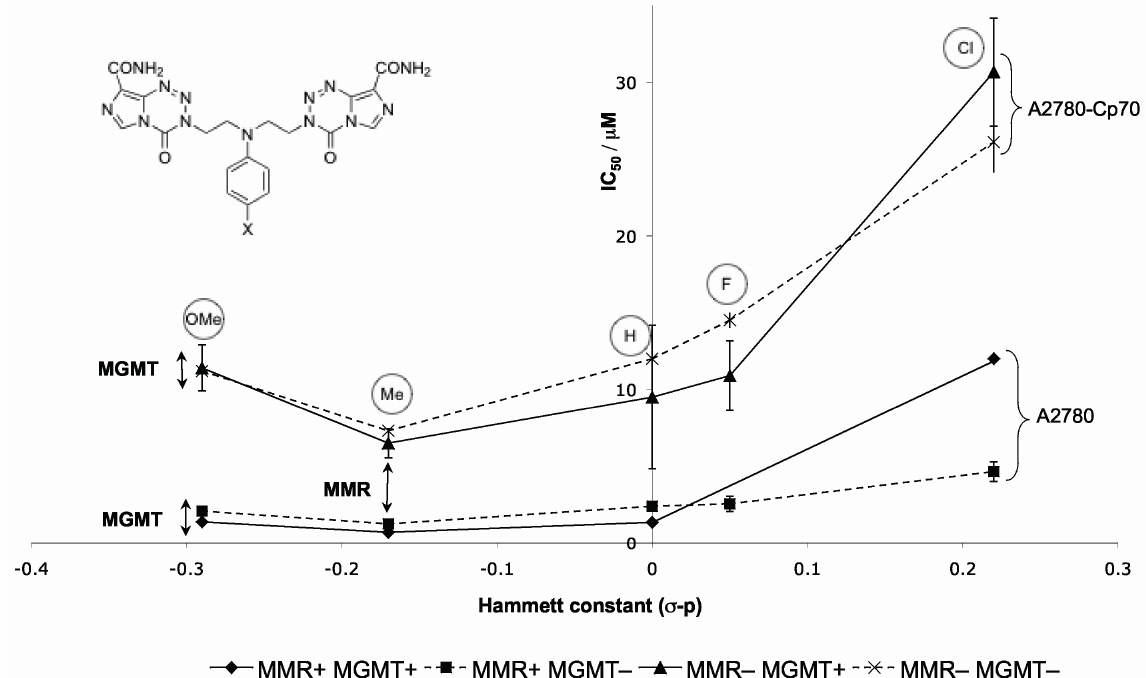
Figure 18. Effect of electron-withdrawing capabilities of substituent X on the activity of aniline dimers 109 [95]. The differences between sets of lines indicate the limited MMR/MGMT